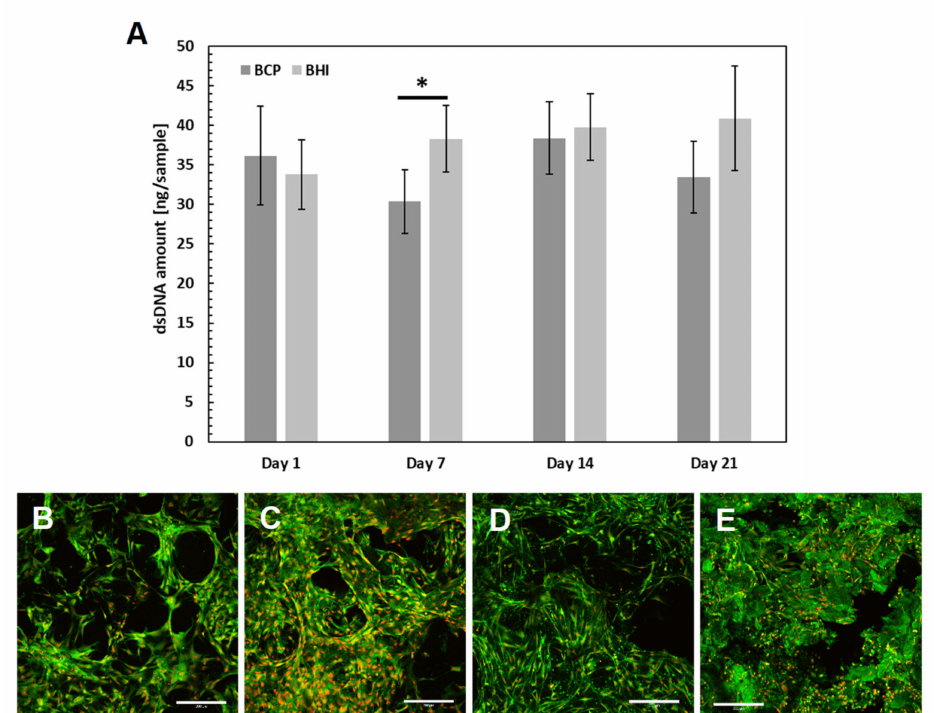
Figure 4. In vitro verification of ceramic implants biocompatibility: hMSC proliferation was measured using dsDNA quantification ( A ). Statistical significance is shown by bars above the columns ( p < 0.05). Visualization of cell adhesion and distribution on scaffolds using a confocal microscope. Biphasic calcium phosphate scaffold (BCP) on day 1 ( B ), bioresorbable hybrid implant (BHI) implant on day 1 ( C ), BCP implant on day 14 ( D ), BHI implant on day 14 ( E ). Cell nuclei were stained using propidium iodide (red color) and intracellular membranes using DiOC6(3) (green color), scale bar 200 µ